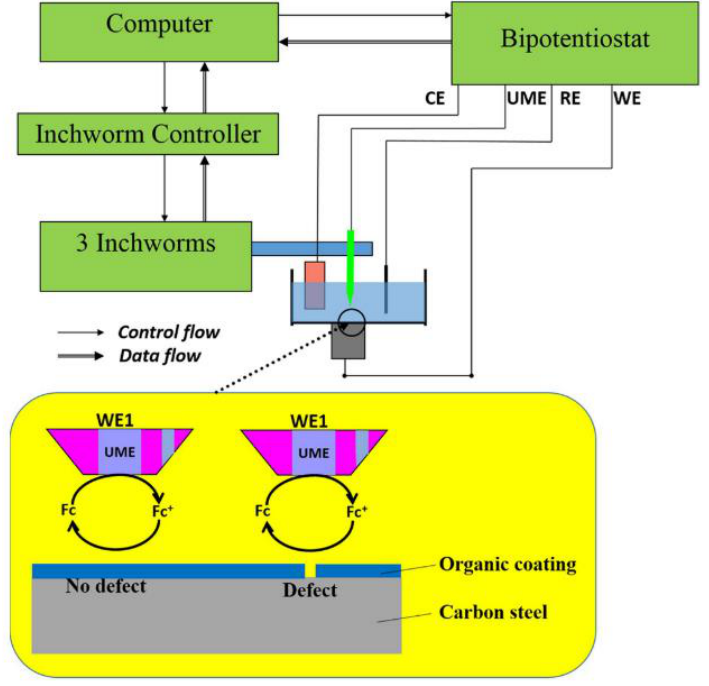
Figure 25. Example SECM (Reprinted with permission from ref. [121]. Copyright 2019 Elsevier).